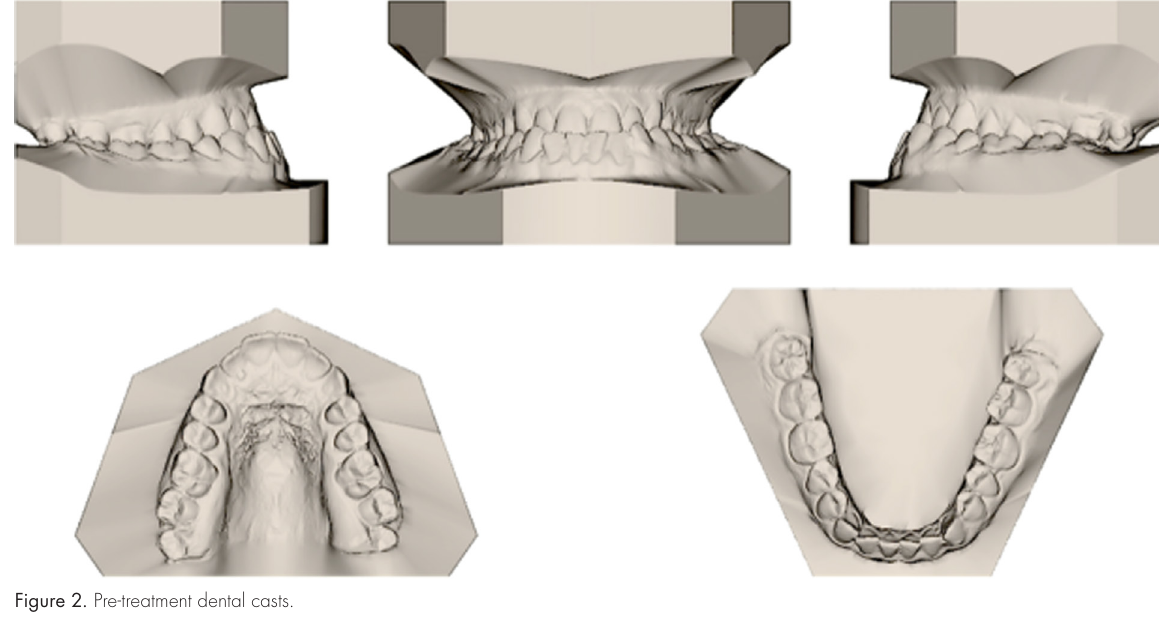
Figure 2. Pre-treatment dental casts.